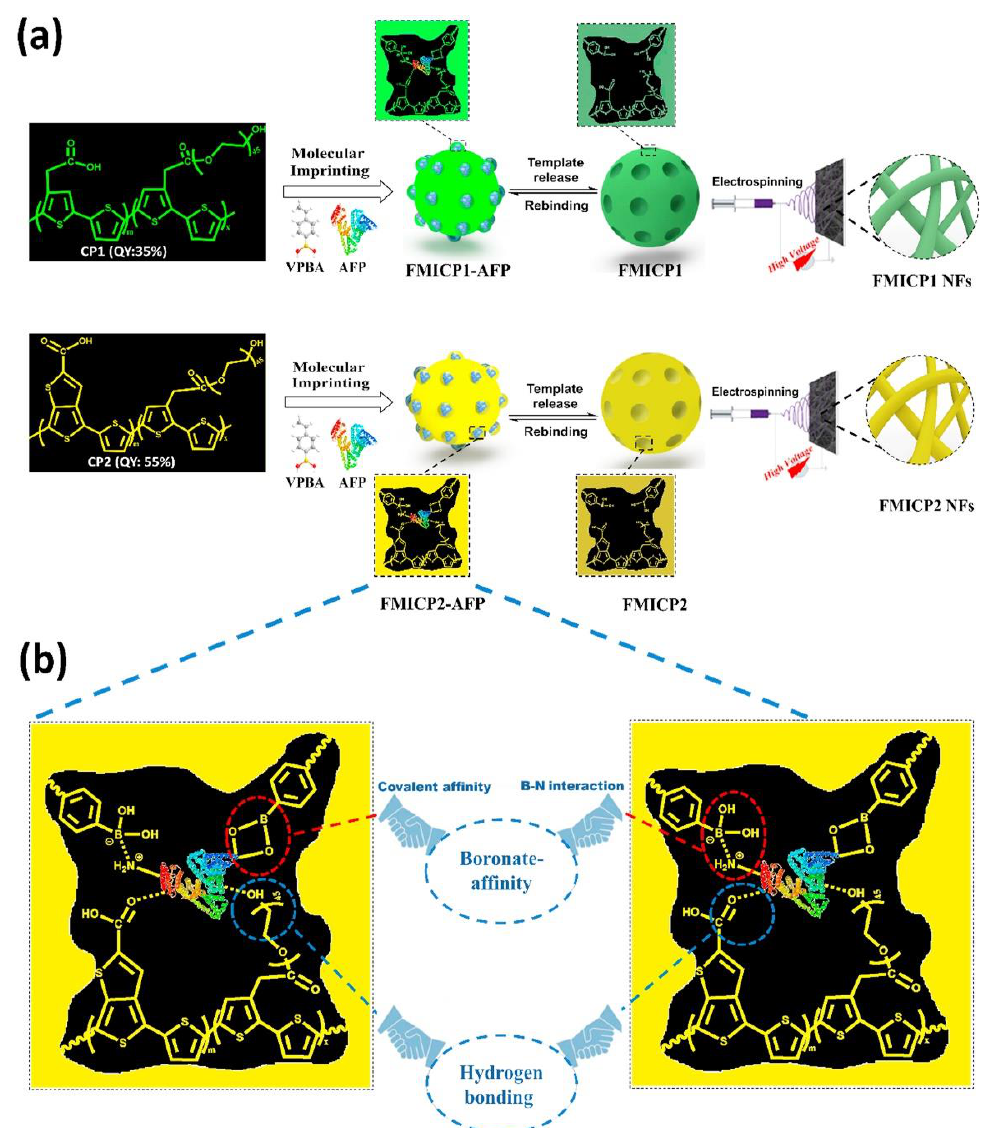
Figure 6. Principle and Strategy of FMICPs and FMICP NFs Biomarkers Assay: ( a ) Synthesis of the conjugated polythiophenes linked—molecular-imprinting strategy and fabrication of their fluorescent nanofibers using an easy and low-cost electrospinning approach, as well as their interactions with AFP biomarker. ( b ) Mechanism of dual-emission CPs linked with boronate-affinity molecular-imprinting strategy. Reproduced with permission from Ref. [77]. Copyright 2020, Elsevier. Notes: